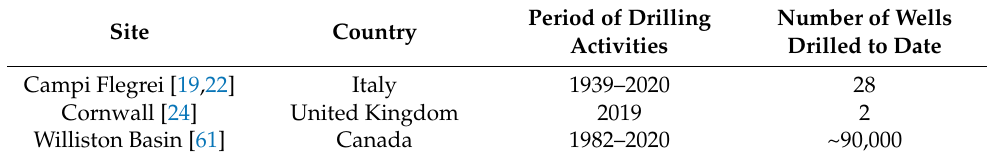
Table 4. Main characteristic of the drilling activities (geothermal and oil and gas) at each